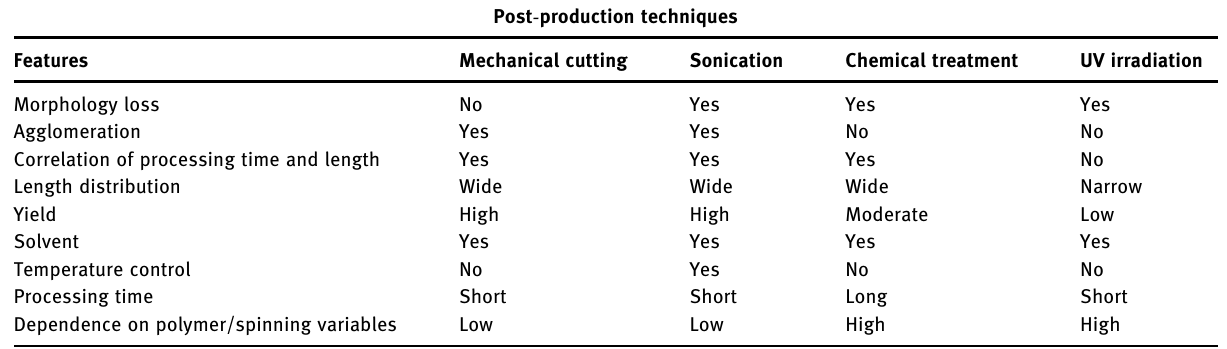
Post - production